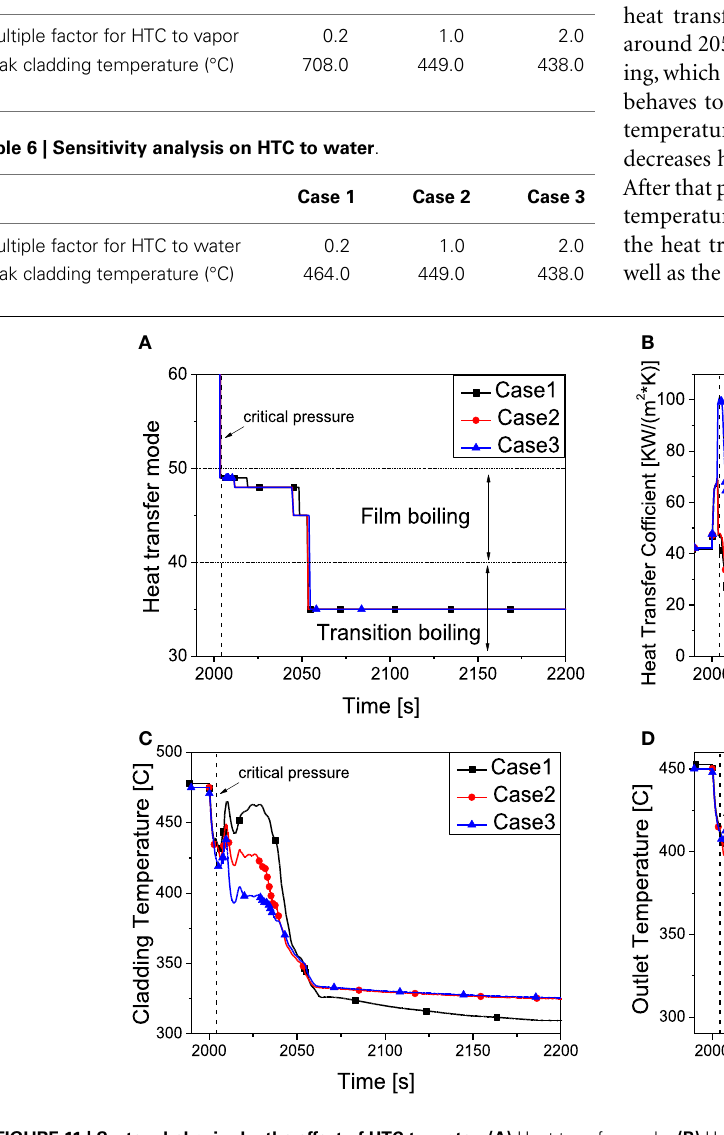
FIGURE 11 | System behavior by the effect of HTC to water . (A) Heat transfer mode. (B) Heat transfer coefficient. (C) Peaking cladding temperature. (D) Core outlet temperature.